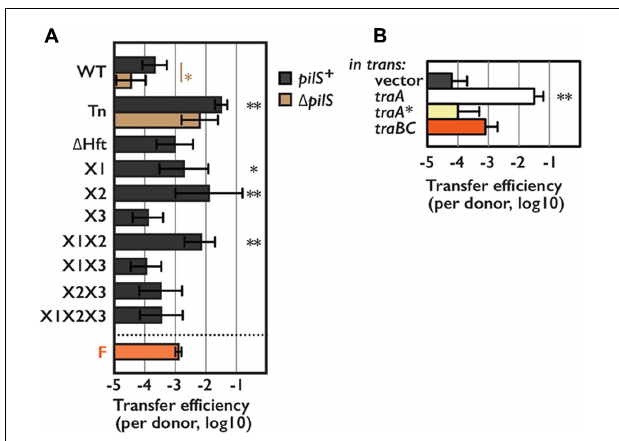
FIGURE 4 | Transfer efficiency of pESBL in snap conjugation. Transfer efficiencies of various pESBL variants (A) or WT pESBL harboring an extra plasmid for overexpression of indicated gene (B) . F plasmid was used for comparison. Average and standard deviation of at least 3 independent experiments were shown. ∗ Indicates p < 0.05 and ∗∗ indicates p < 0.01,